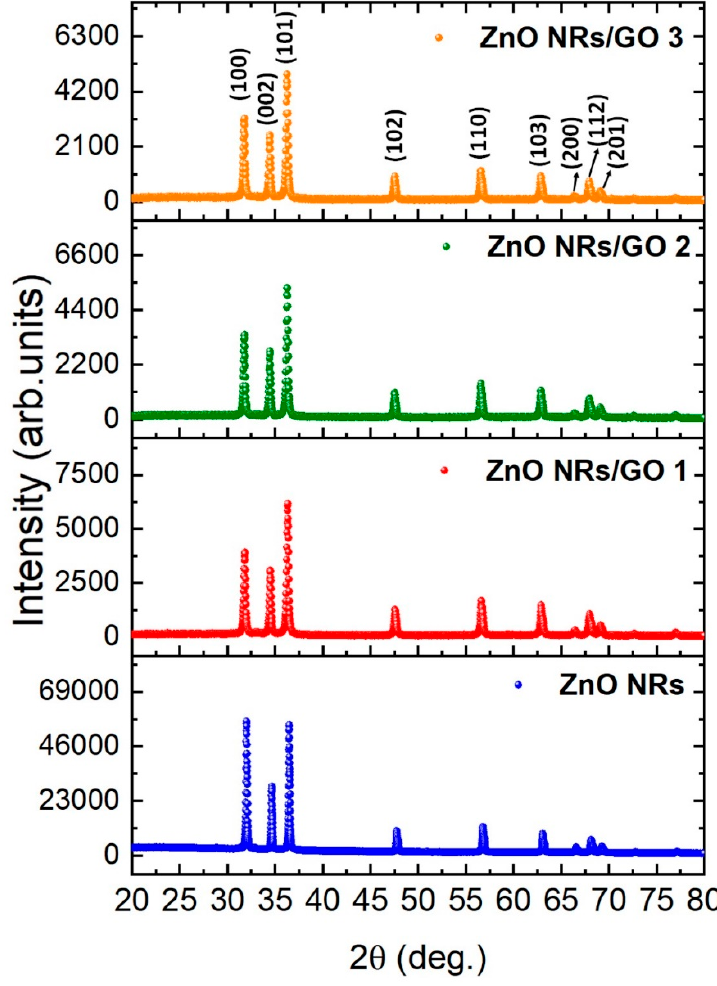
Figure 2. X-ray di ff raction (XRD) patterns of ZnO NRs and ZnO NRs / GO nanocomposites with di ff erent Figure 2. X-ray diffraction (XRD) patterns of ZnO NRs and ZnO NRs/GO nanocomposites with concentrations of different concentrations of GO.